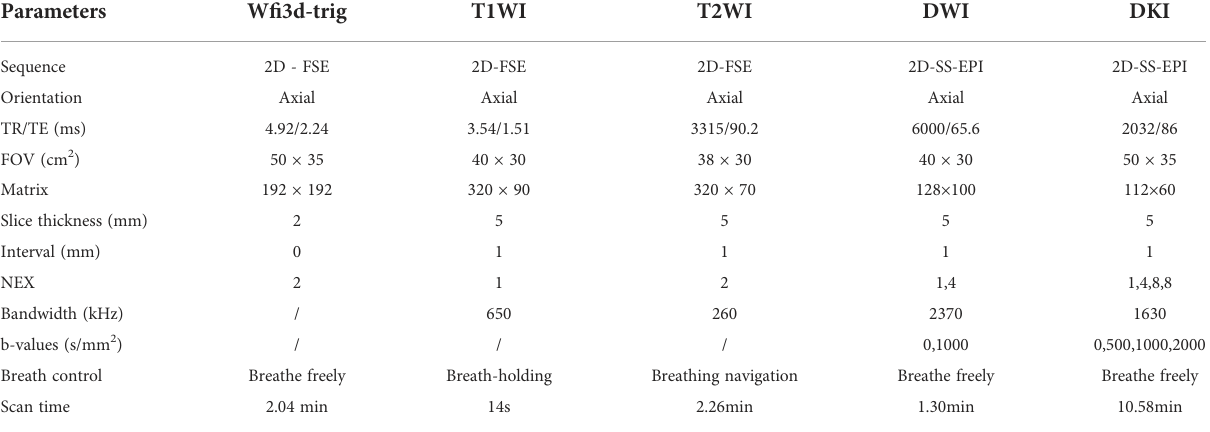
TABLE 1 MRI acquisition